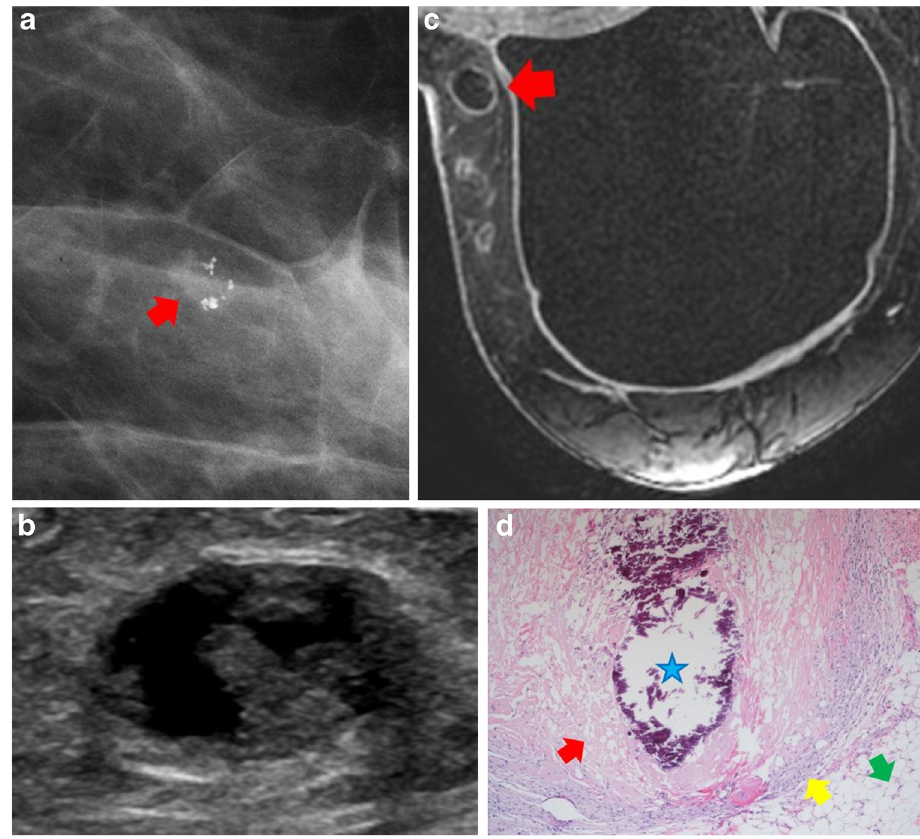
Fig. 5 Fat necrosis. A 48-year- old woman with prior bilateral prophylactic mastectomies and implant reconstruction presented with a palpable abnormality on the inner aspect ofthe right